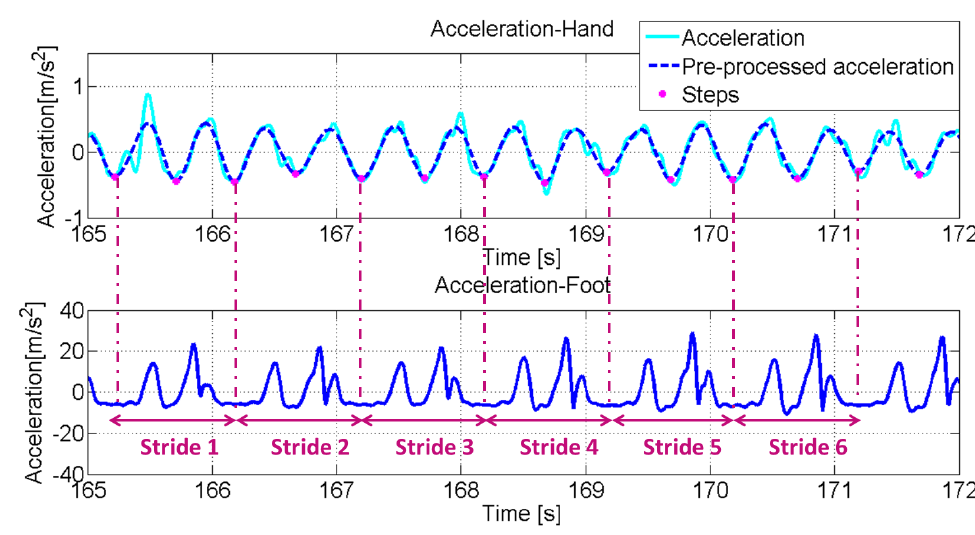
Figure 9. (Upper) Accelerometer signal (norm) recorded by the IMU in the texting hand. The dots represent the detected step events. (Down) Accelerometer signal (norm) recorded by the IMU on the foot (the mean has been removed).